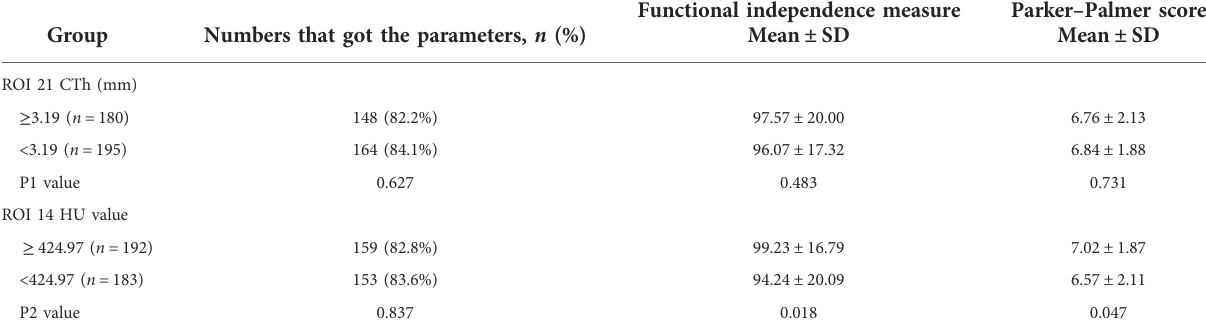
TABLE 6 Functional ability by the group.